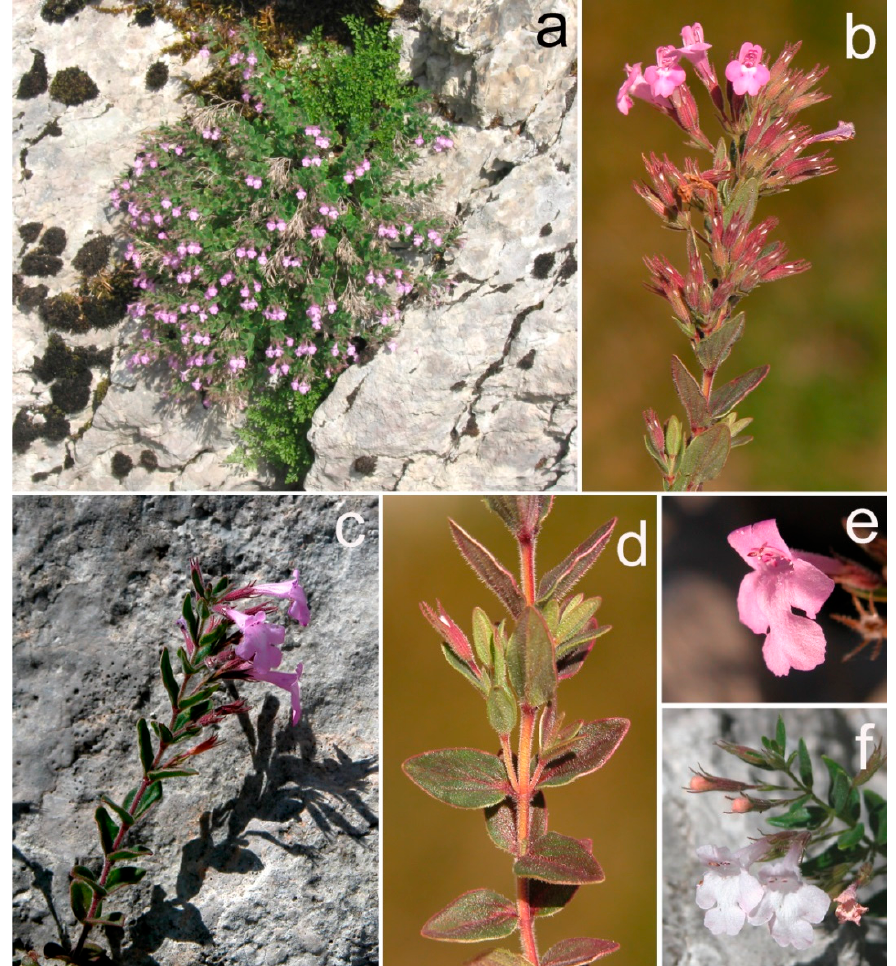
Figure 1. Habitus ( a ), shoot with leaves and flowers ( b , c ), hairy leaves and stem ( d ), pink–purple ( a – c , e ), and white ( f ) flowers of Micromeria croatica